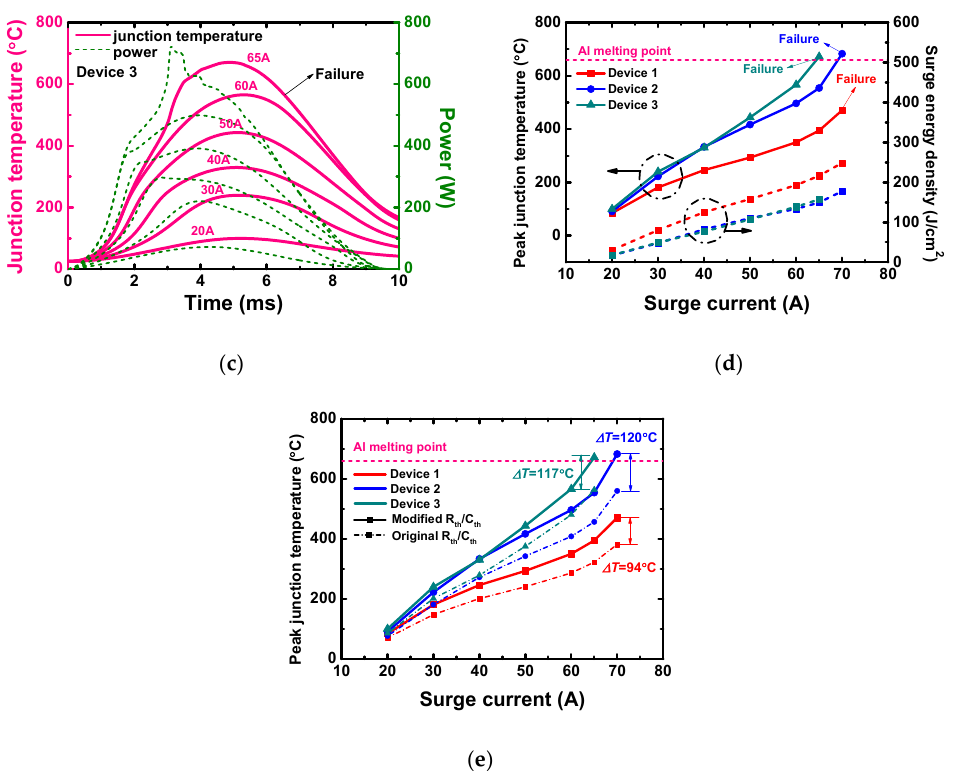
Figure 15. ( a – c ) The junction temperature and surge heating power of the three devices during the surge tests in Section 2.3, calculated by importing the thermal parameters in Figure 14 into the compact RC model. ( d ) The peak junction temperature and the surge energy density during the surge tests of the three devices. ( e ) The comparison of the peak junction temperature, calculated by the modified thermal impedance in Figure 14 and by the original thermal impedance in Figure 11 of the three devices.